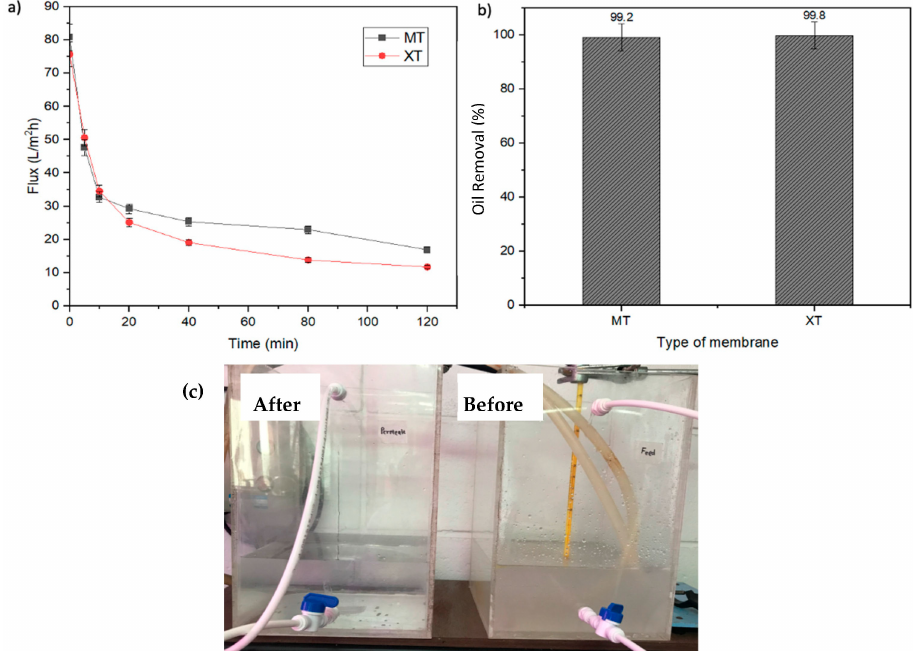
Figure 7. Performance of MT and XT membrane via MD method, highlighting ( a ) flux and ( b ) oil removal percentage. ( c ) The digital photographs show OW color difference before and after the MD